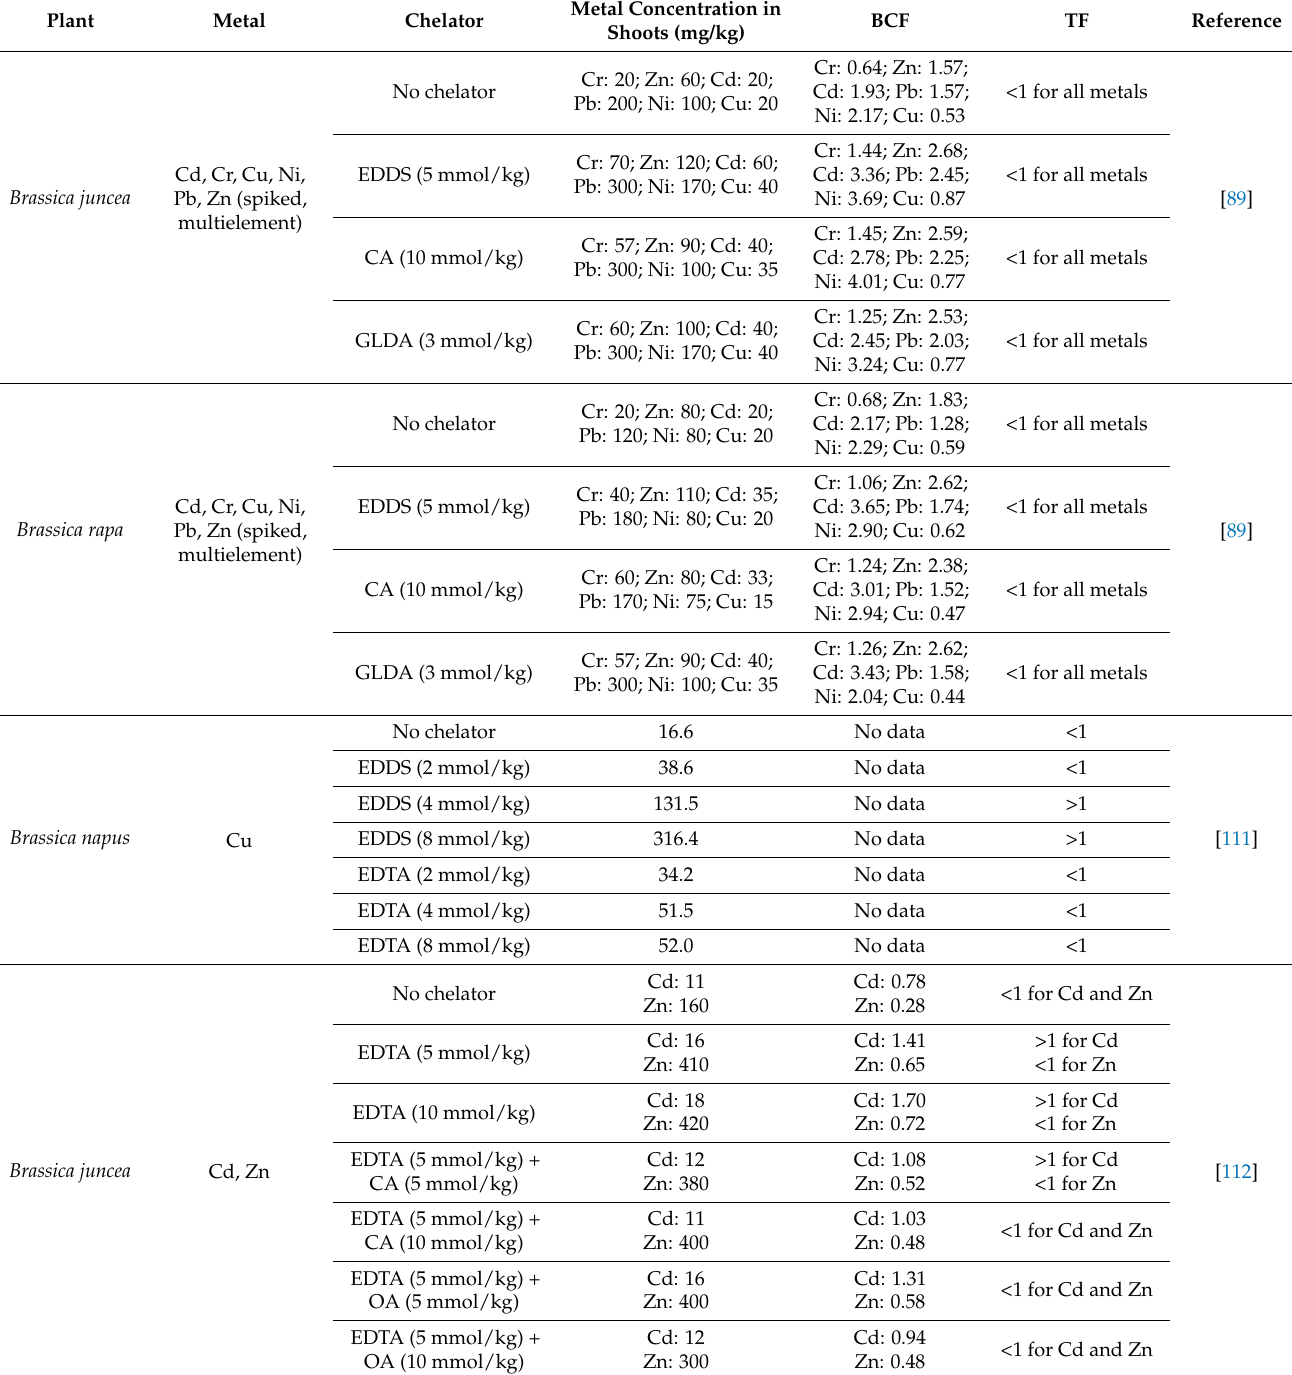
Table 3. Metal concentration in shoots, bioconcentration and translocation factors for Brassica plants after chelator applica-